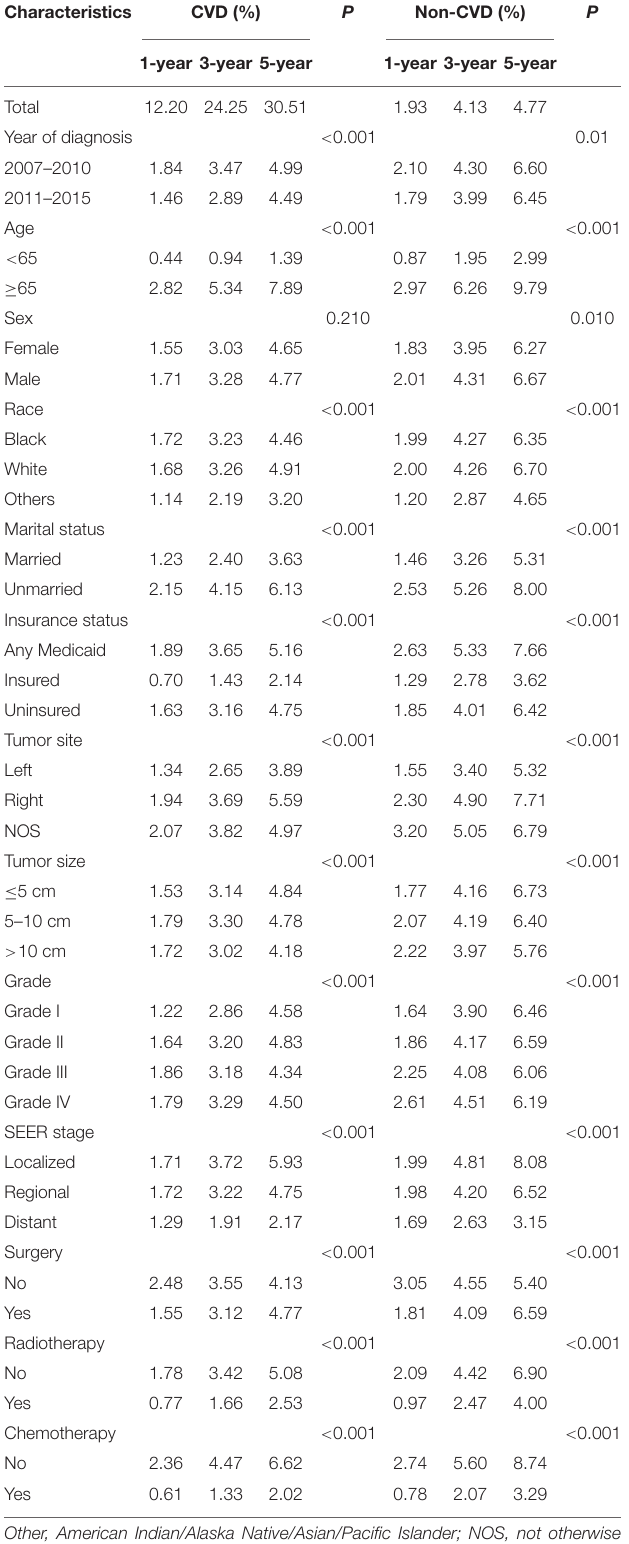
TABLE 2 | Cumulative incidence of cause-specific death and Gray’s test in the whole set.